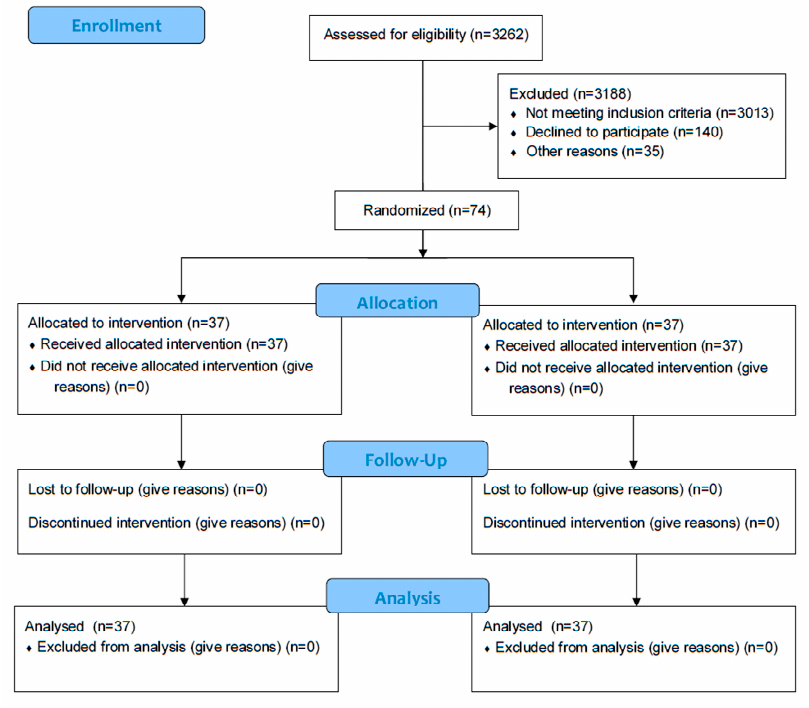
Figure 1. Participant flow diagram.